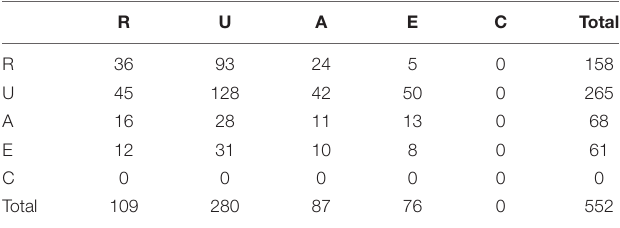
TABLE 7 | Frequency of effective single sequences in the first and second team in five debates.